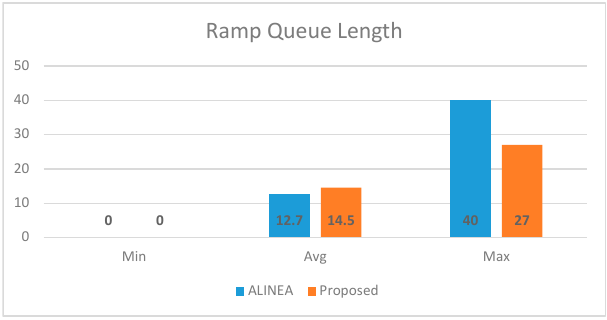
Figure 20. Ramp queue length comparison.